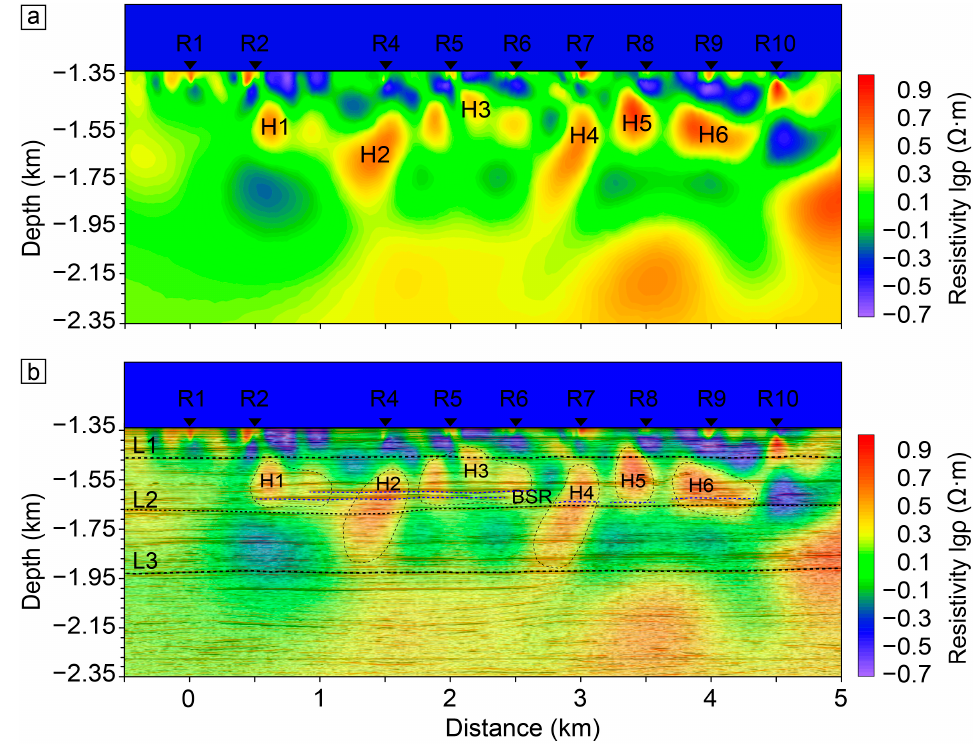
Figure 7. ( a ) The resistivity model was obtained from the 2D inversion of 8 Hz Pmax data; ( b ) The MCSEM result in ( a ) is overlapped by the seismic profile. The black, dashed lines are the resistivity interfaces, and the blue, dashed lines are the deduced BSR of the seismic